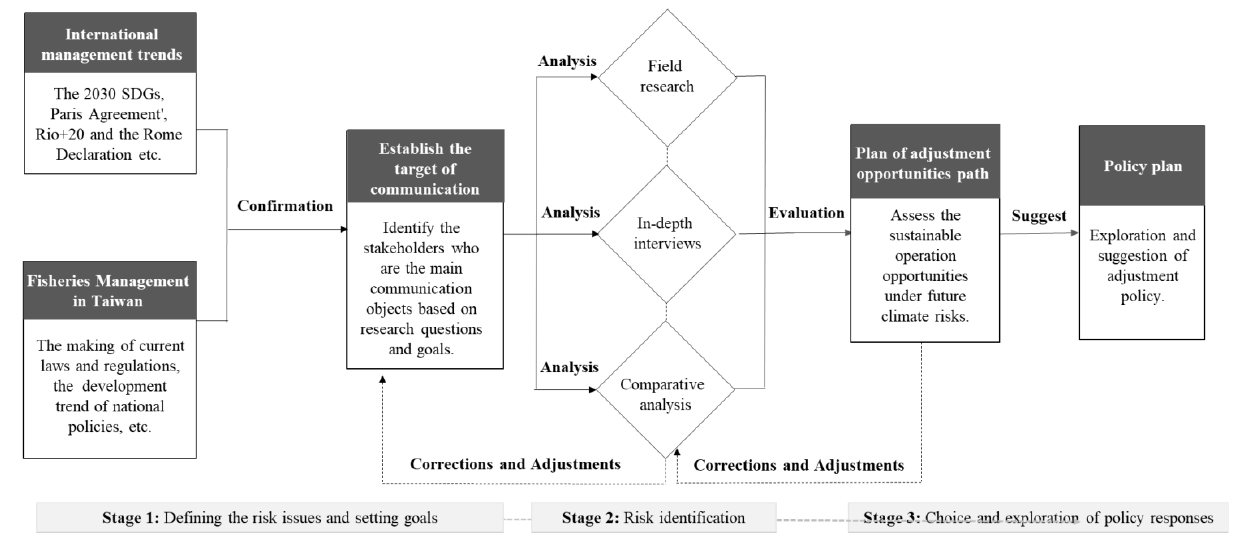
Figure 3. Climate risk assessment process and stakeholder participatory cooperation.